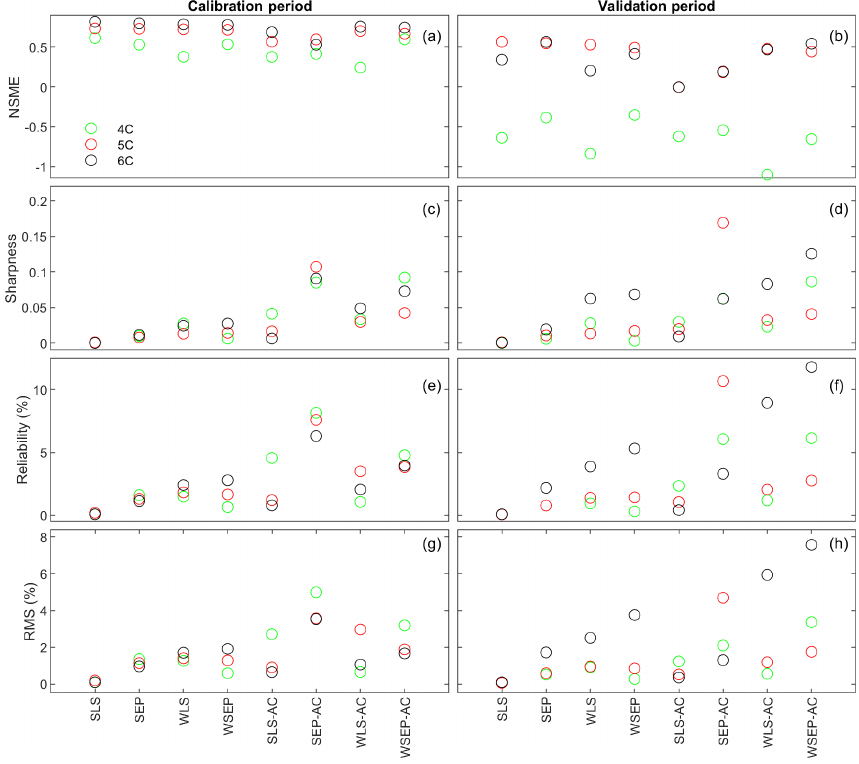
Figure 7. (a, b) Nash–Sutcliffe model efficiency (NSME), (c, d) sharpness, (e, f) predictive coverage, and (g, h) relative model score for measuring predictive performance of the three soil respiration models and the eight data models during the calibration and cross-validation periods. The statistics are evaluated from the prediction ensembles generated to consider parametric uncertainty of the soil respiration models